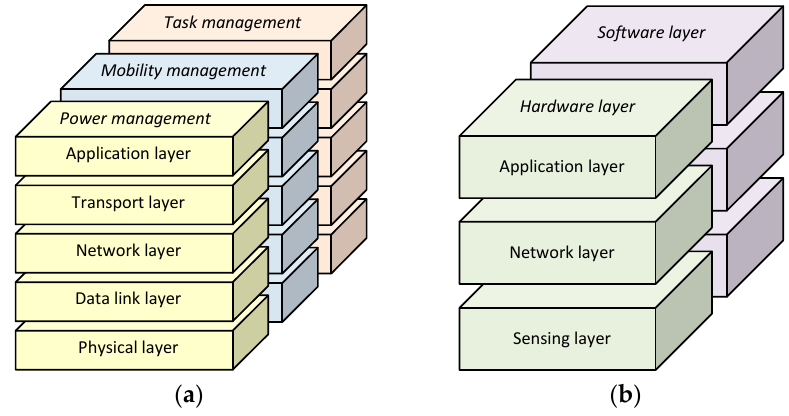
Figure 1. Sensor network: ( a ) General architecture [24]; ( b ) Functional orientation [14].